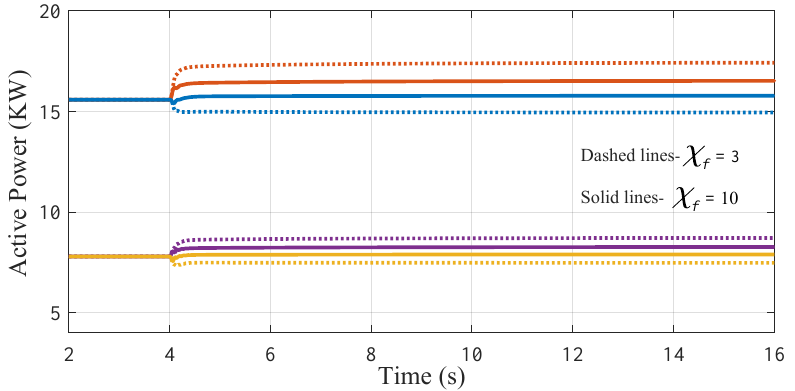
Figure 8. Comparative active power performance under unbounded actuator attacks with different adaptive tuning